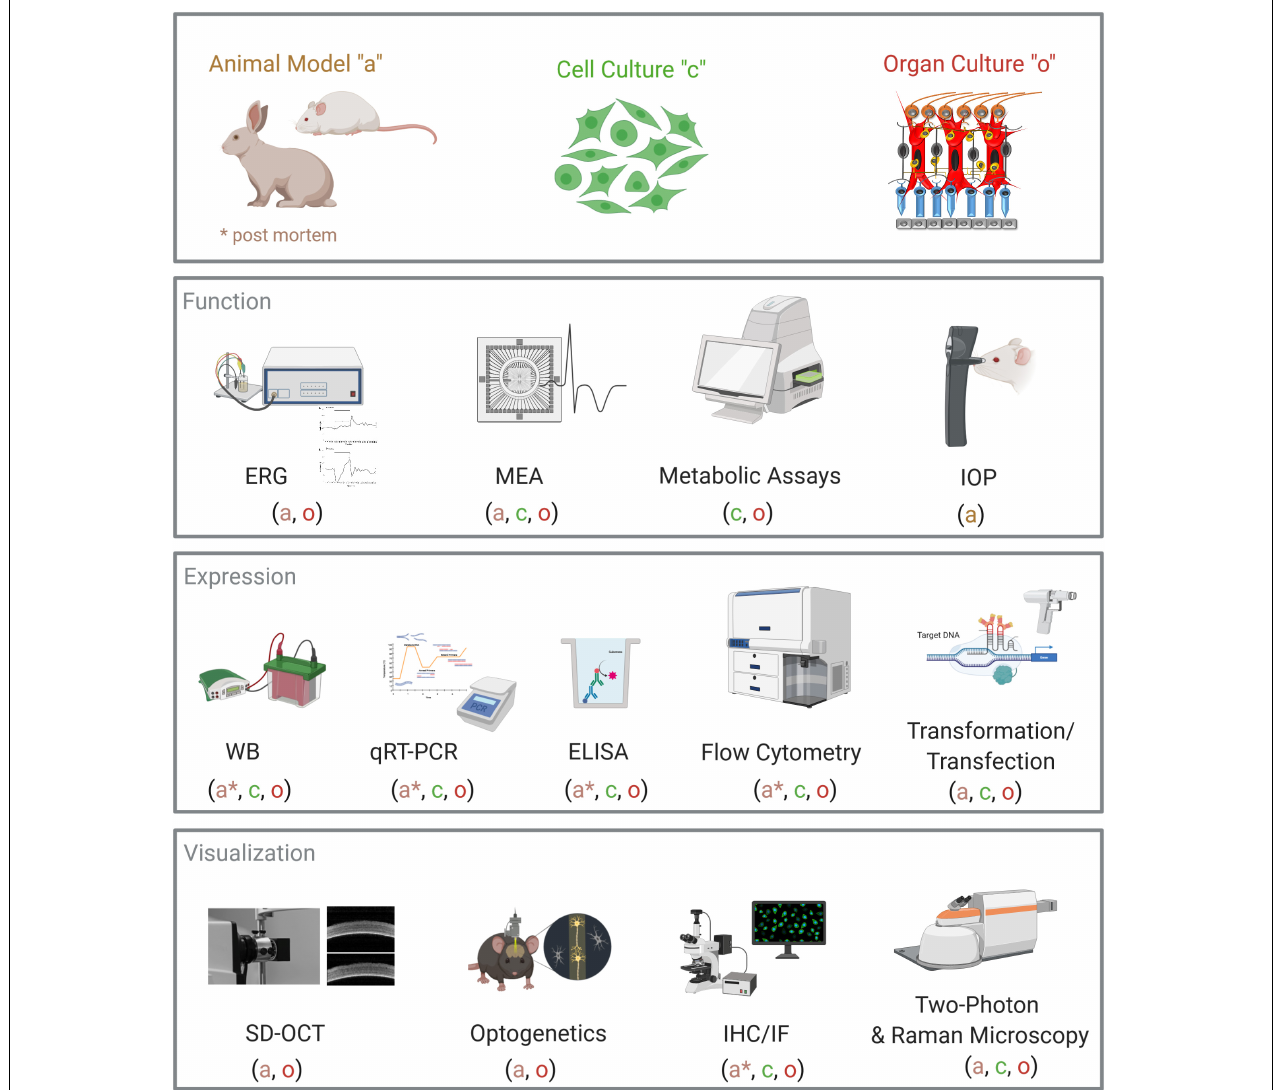
FIGURE 1 | Overview of analytical methods for retinal organ cultures. Common laboratory and diagnostic methods are displayed. For each method, it is noted if it can be performed on animal models (a), on cell cultures (c), or on organ cultures (o). Abbreviations: ERG, electroretinogram; MEA, microelectrode array; IOP, intraocular pressure; WB, Western blot; qRT-PCR, quantitative real-time PCR; ELISA, enzyme-linked immunosorbent assay; SD-OCT, spectral domain optical coherence tomography; IHC, immunohistochemistry; IF, immunofluorescence. Created with